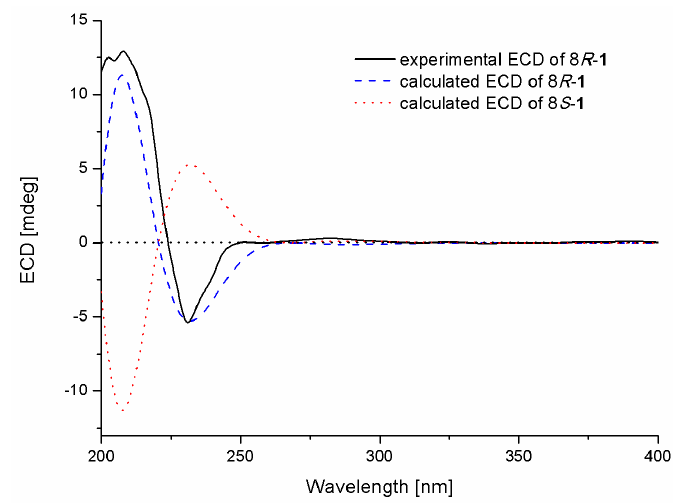
Figure 3. Experimental and calculated ECD spectra of compound 1 .